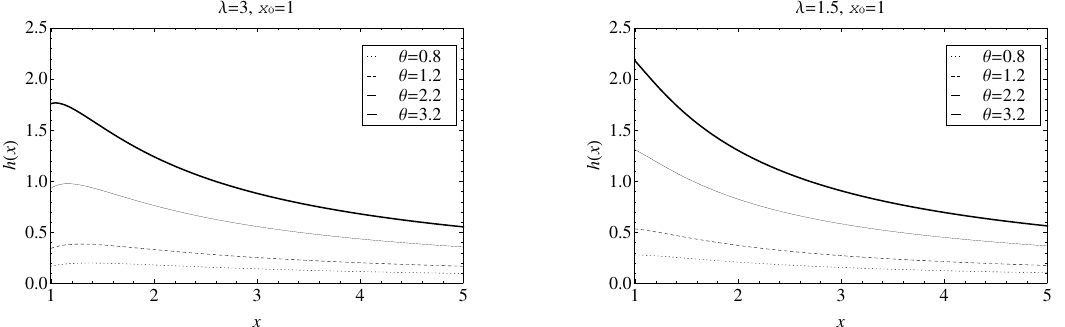
Figure 2. Graphs of the hazard rate function (4) for different values of parameter θ , λ and for fixed value of x 0